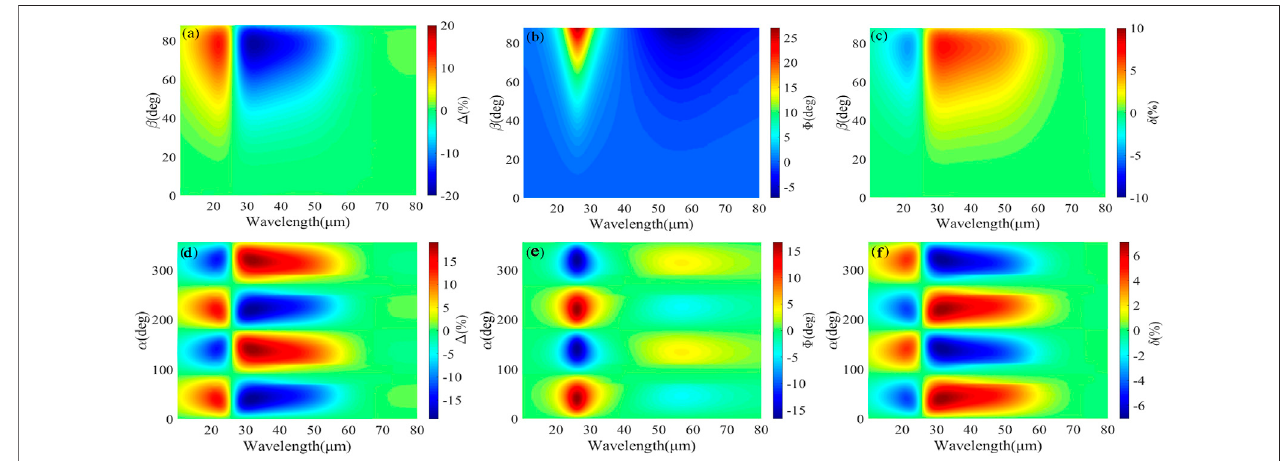
FIGURE 4 | Dependences of (A) circular dichroism Δ , (B) circular birefringence Φ , and (C) circular conversion dichroism δ on the elevation angle β . Here, α = 45 ° . Dependences of (D) circular dichroism Δ , (E) circular birefringence Φ , and (F) circular conversion dichroism δ on the azimuthal angle α . Here, β = 75 ° .